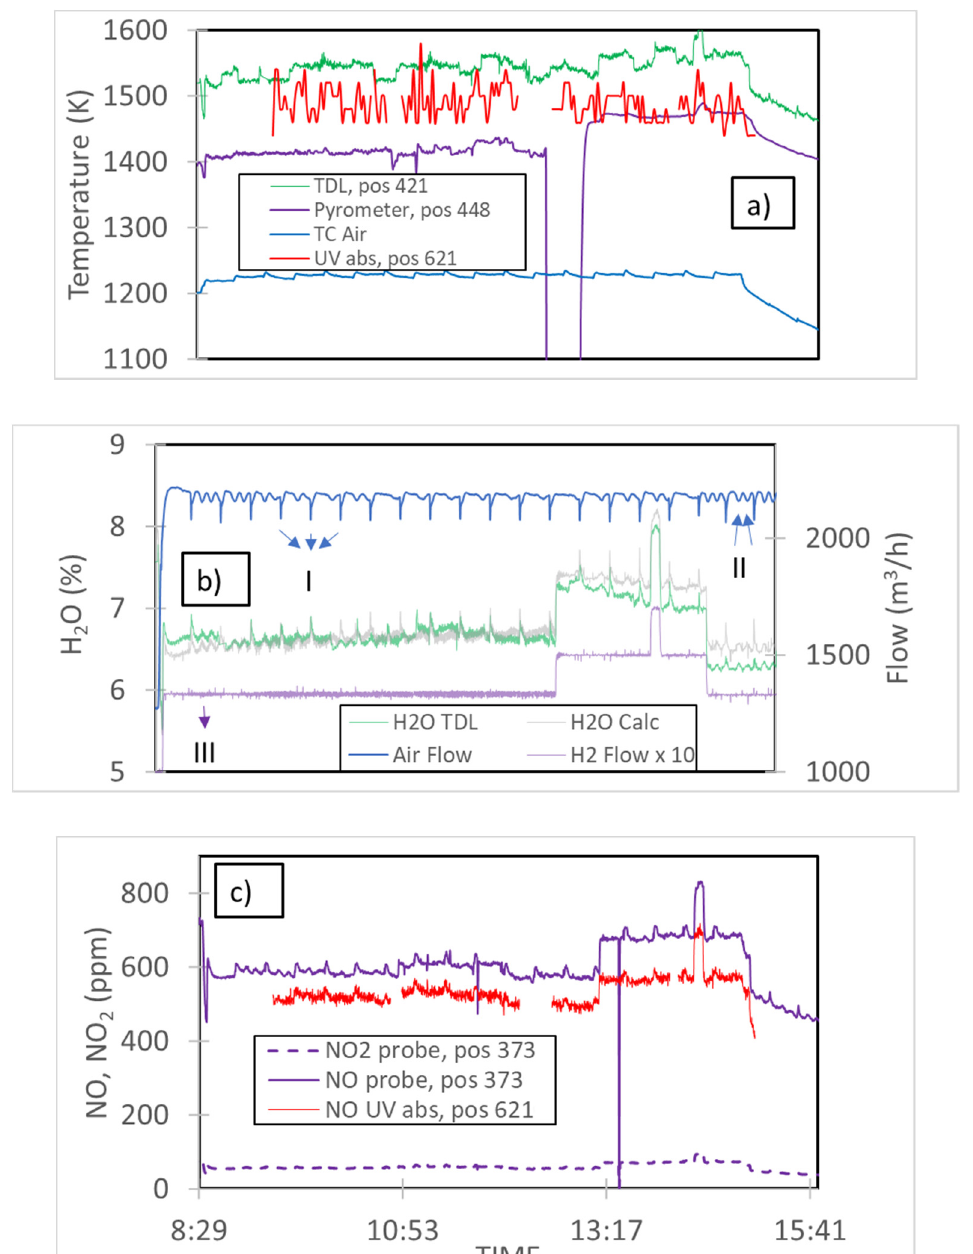
Figure 3. Online measurements of T (TDL, UV absorption, Suction pyrometer, TC) ( a ), H 2 O (TDL) and flows of process air and hydrogen ( b ), NO (UV absorption) and NO and NO 2 (Probe) ( c ) during the combustion of hydrogen. Position number in the legend (pos nnn) shows the distance in cm from the beginning of the ECF to the measurement position. UV absorption T averaged over 100 s; UV absorption NO is fitted using fixed T = 1480 K.